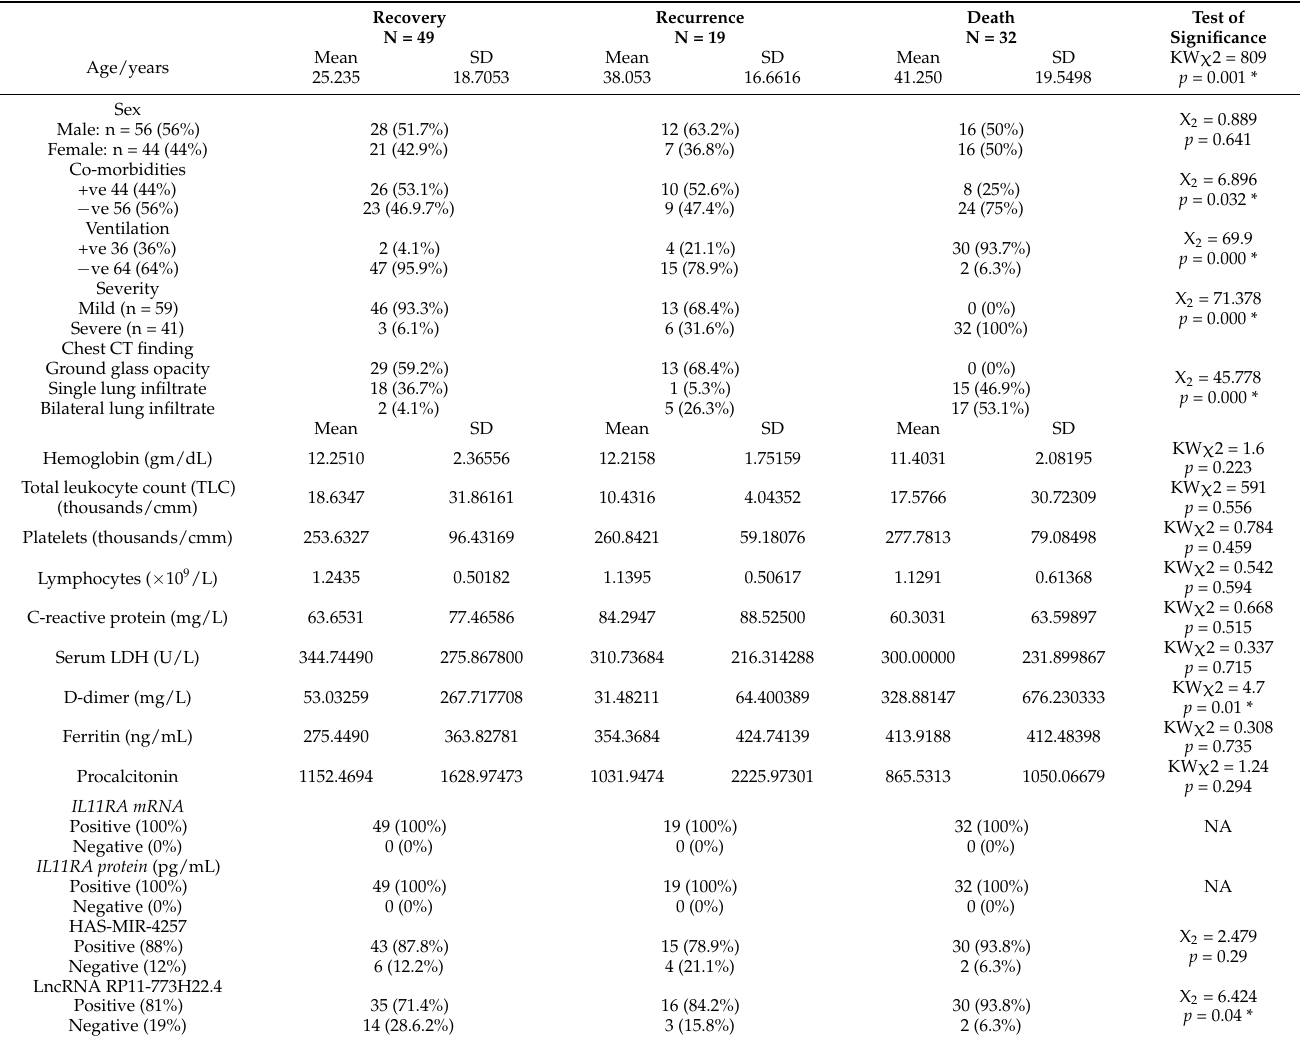
Table 4. Predictors’ outcomes regarding COVID-19 severity in infected